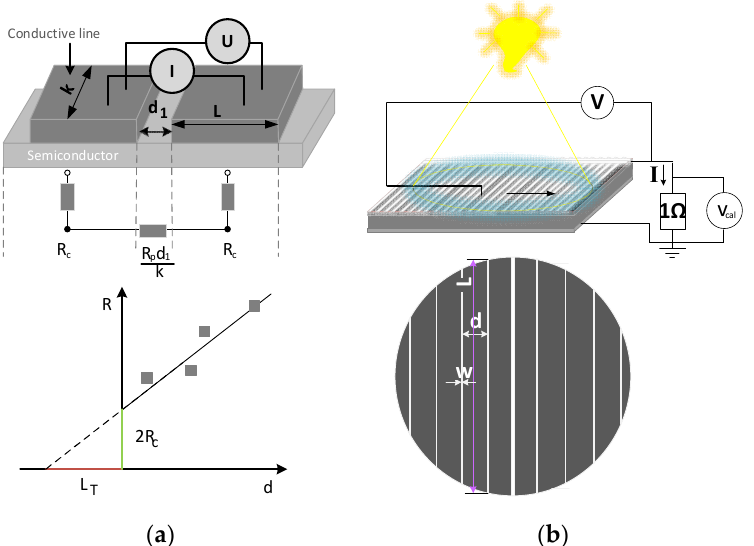
Figure 1. Graphical illustration of the methods of ( a ) TLM (where R—resistance; R p —surface resistance; I—current; U—voltage; k—electrode line length; d—distance between electrode path lines; L T —electrode line width to the effect of current; R c —contact resistance) and ( b ) PD (where w—path width; d—distance between the electrode path lines; L—path length; V—voltage on the front electrode, measured through a metal probe in direct contact with its surface) [33,34].